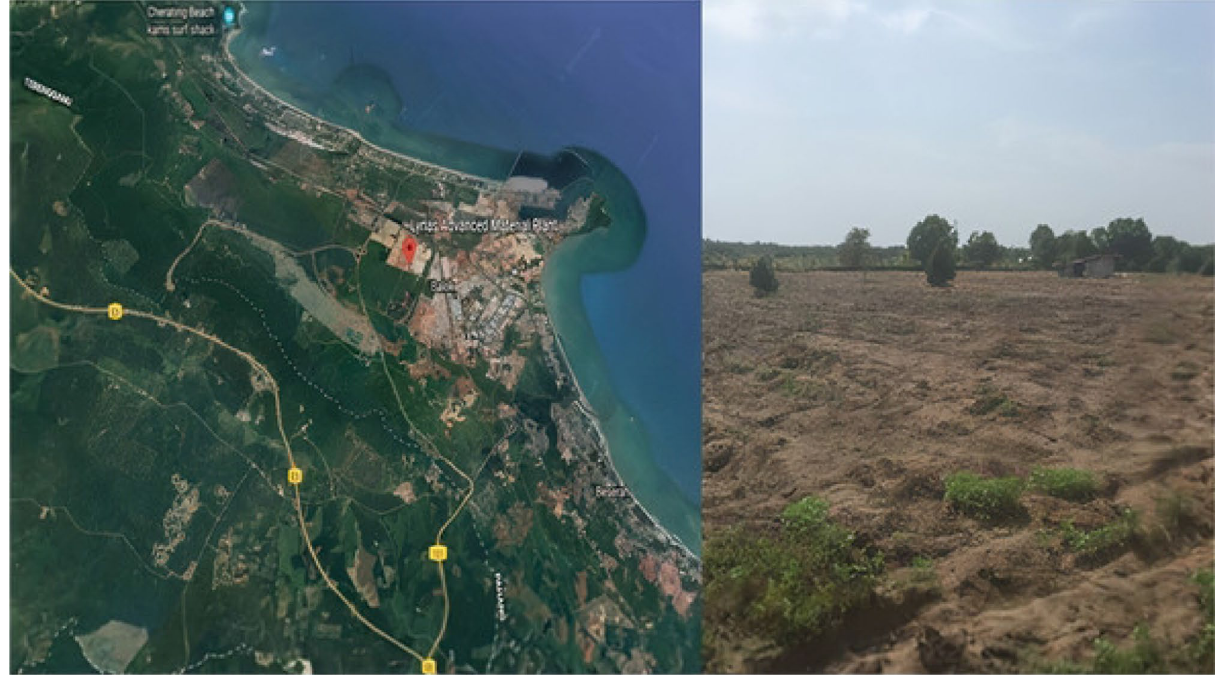
Figure 3. The location of the experimental site and the Lynas Advance Material Plant (LAMP) 71 ; Note: Scale of map; 1.0 cm = 1.0